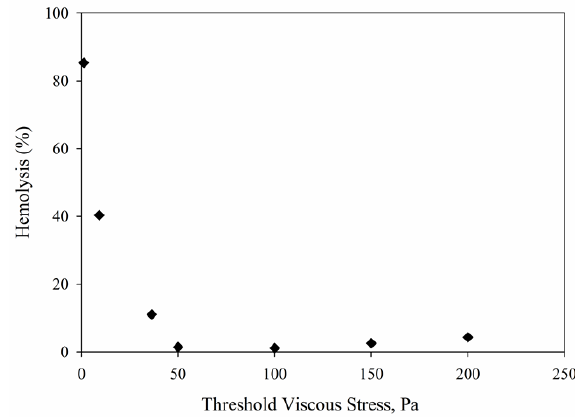
Figure 6. Relationship of hemolysis to threshold viscous stresses in Couette viscometer for all experiments (450 to 50 Pa).